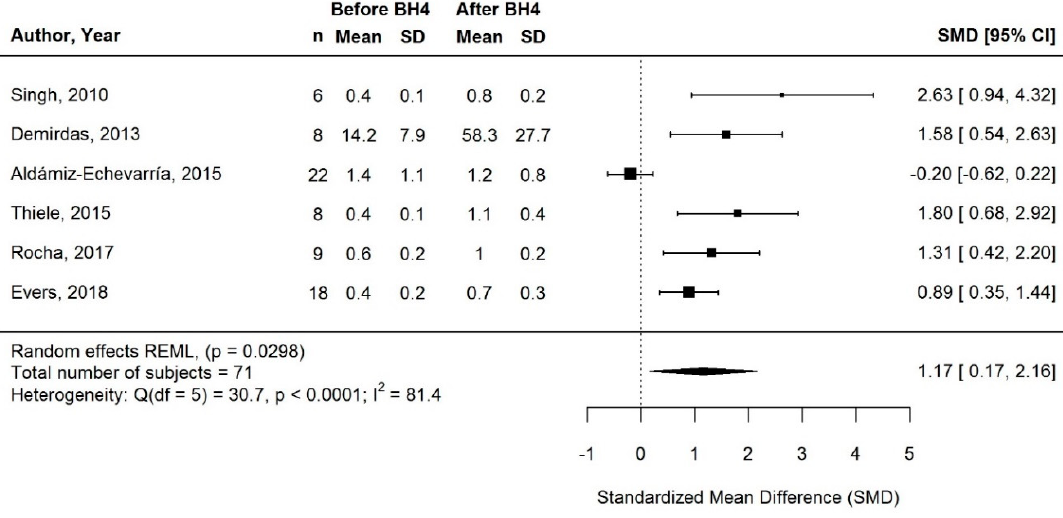
Figure 3. Standardized change in natural protein intake of long-term responders on BH4 treatment. Means and SDs before/after BH4 are gram natural protein per day for Demirdas (2013), and gram per kilogram bodyweight per day for all other studies. Abbreviations: BH4, tetrahydrobiopterin; CI: confidence interval; n: sample size; SD: standard deviation; SMD, standardized mean difference.